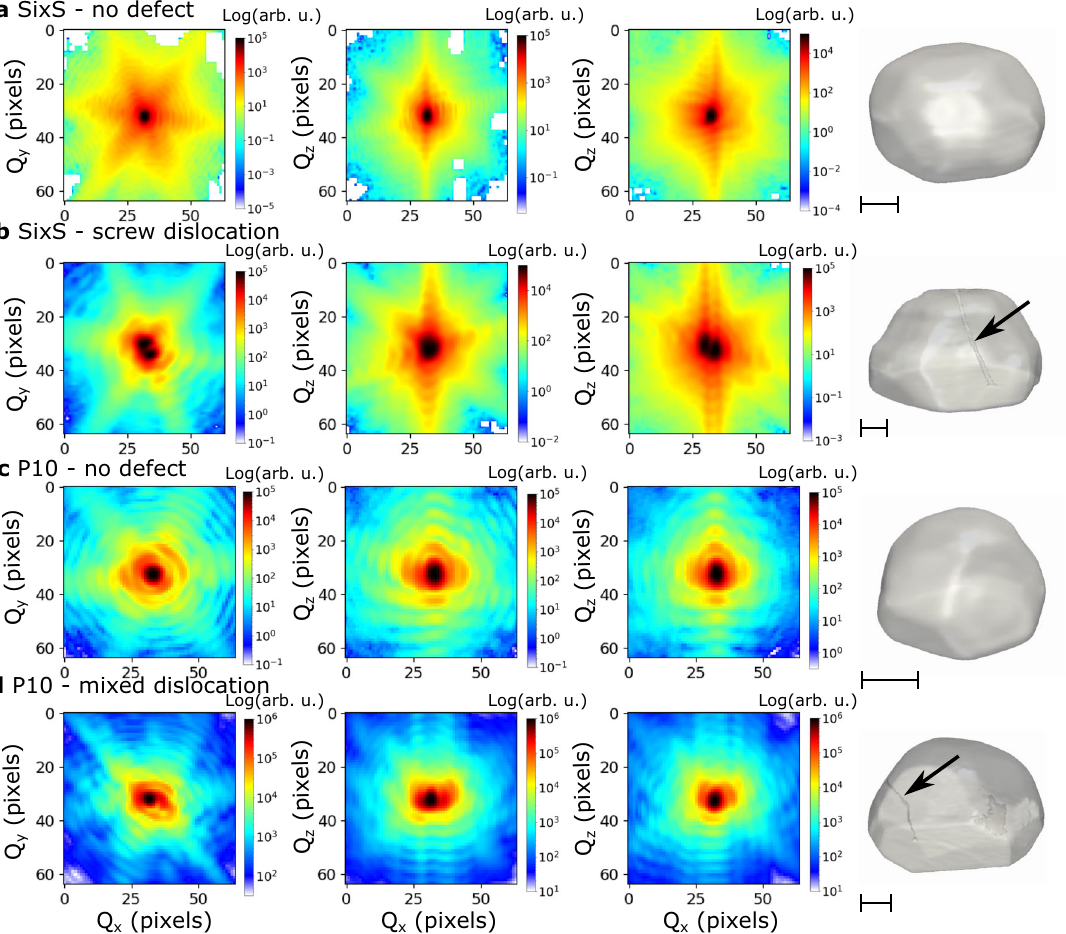
Fig. 3 CXDPs and reconstructed Bragg electron density from Pt NPs measured on the P10 and SixS beamlines. a Defect-free NP, SixS beamline b Defective NP, SixS beamline c Defect-free NP, P10 beamline d Defective NP, P10 beamline. The black arrows indicate the location of the dislocations. The scale bar indicates a length of 100 nm. The CXDPs are on a logarithmic scale to enhance the fringes